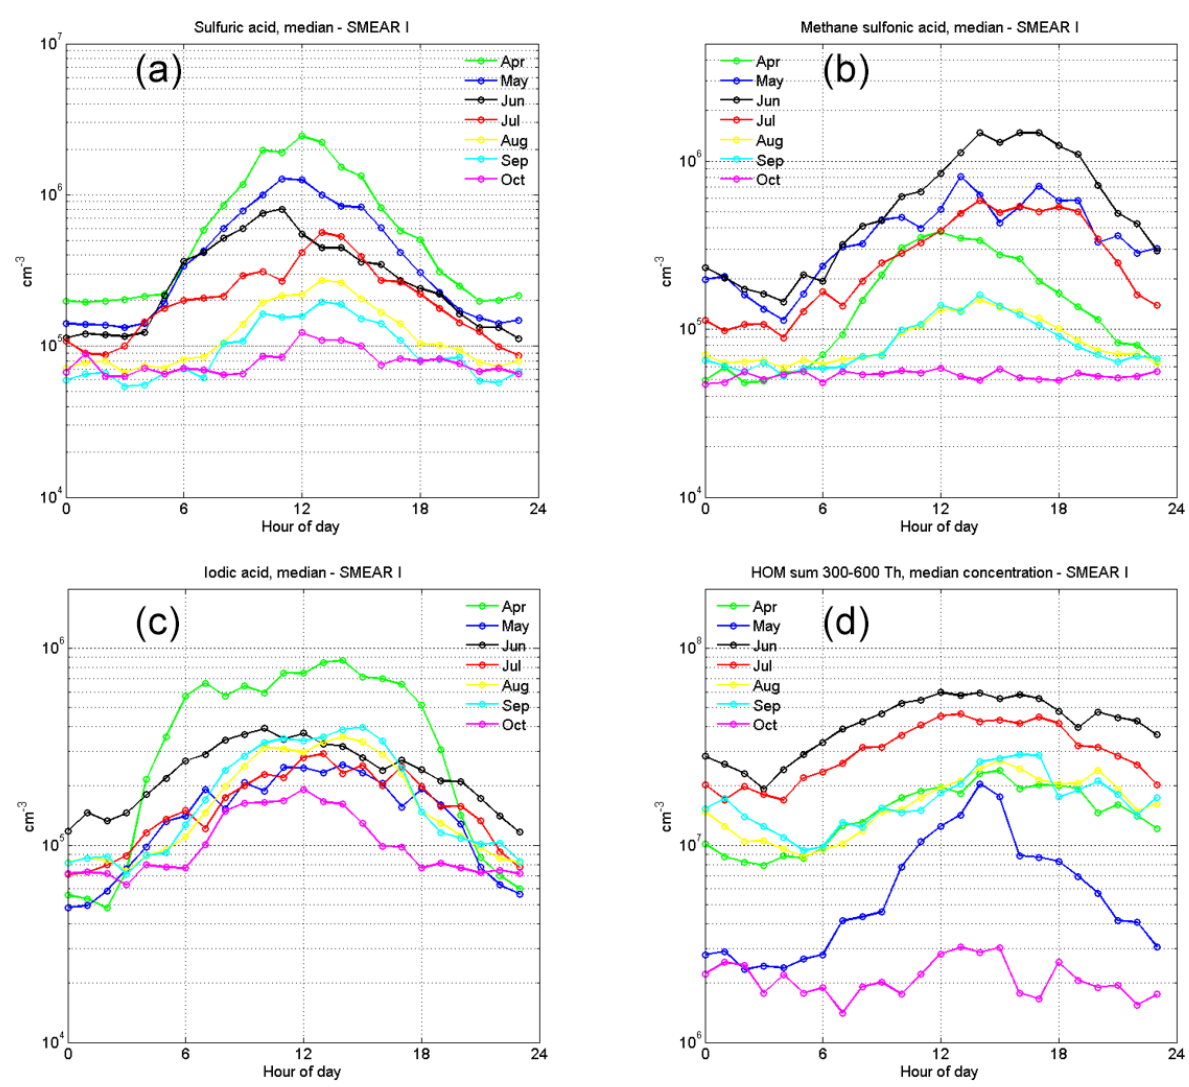
Figure 4. Monthly median concentrations of (a) sulfuric acid, (b) methane sulfonic acid, (c) iodic acid and (d) the sum of HOMs in the 300 to 600Th mass